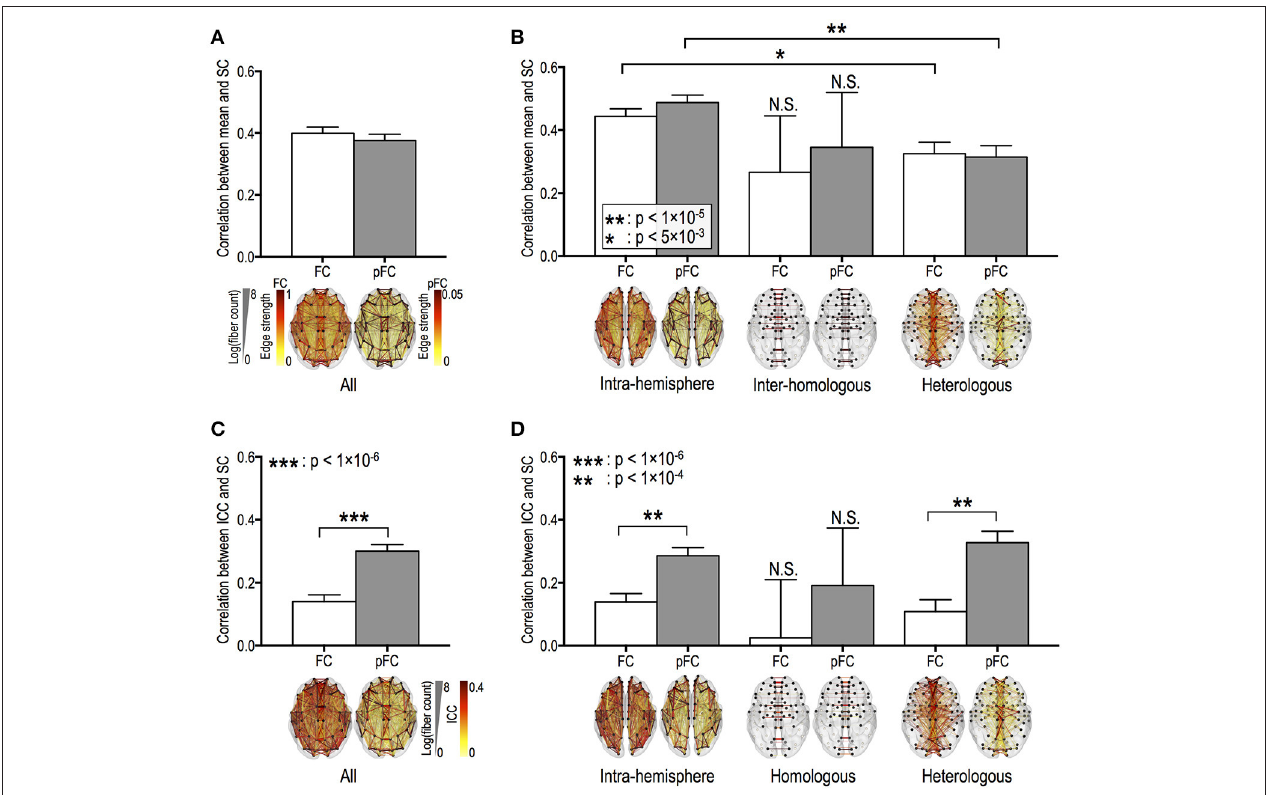
FIGURE 3 | Relationships between the stability of functional connectivity and structural connectivity according to edge types. The relationships between functional connectivity strength and structural connectivity (SC, defined by log-transformed fiber counts) for whole brain edges (A) and for intra-hemispheric edges and for inter-hemispheric homologous/heterologous edges (B) . The relationships between intra-class correlations (ICCs, stability) of functional connectivity and log-transformed fiber counts in the different edge types (C,D) . FC: Pearson correlation-based functional connectivity, pFC: partial correlation-based functional connectivity. N.S. represents “no significant